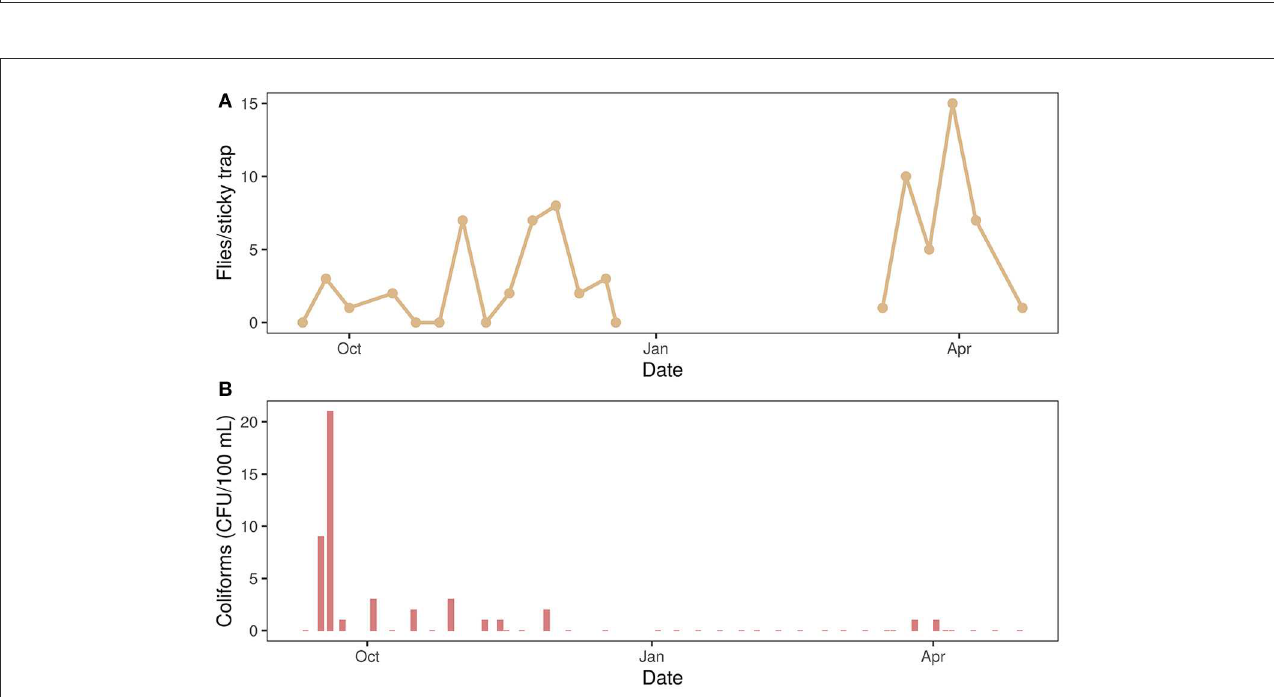
FIGURE3 (A) The number of face flies ( Musca autumnalis ) caught on sticky traps and (B) concentration of coliforms (CFU/100mL) in drinking water of water tower A. Monitoring was performed weekly from September 2019 until the end of April 2020. From the end of December 2019 until March 2020, flies were